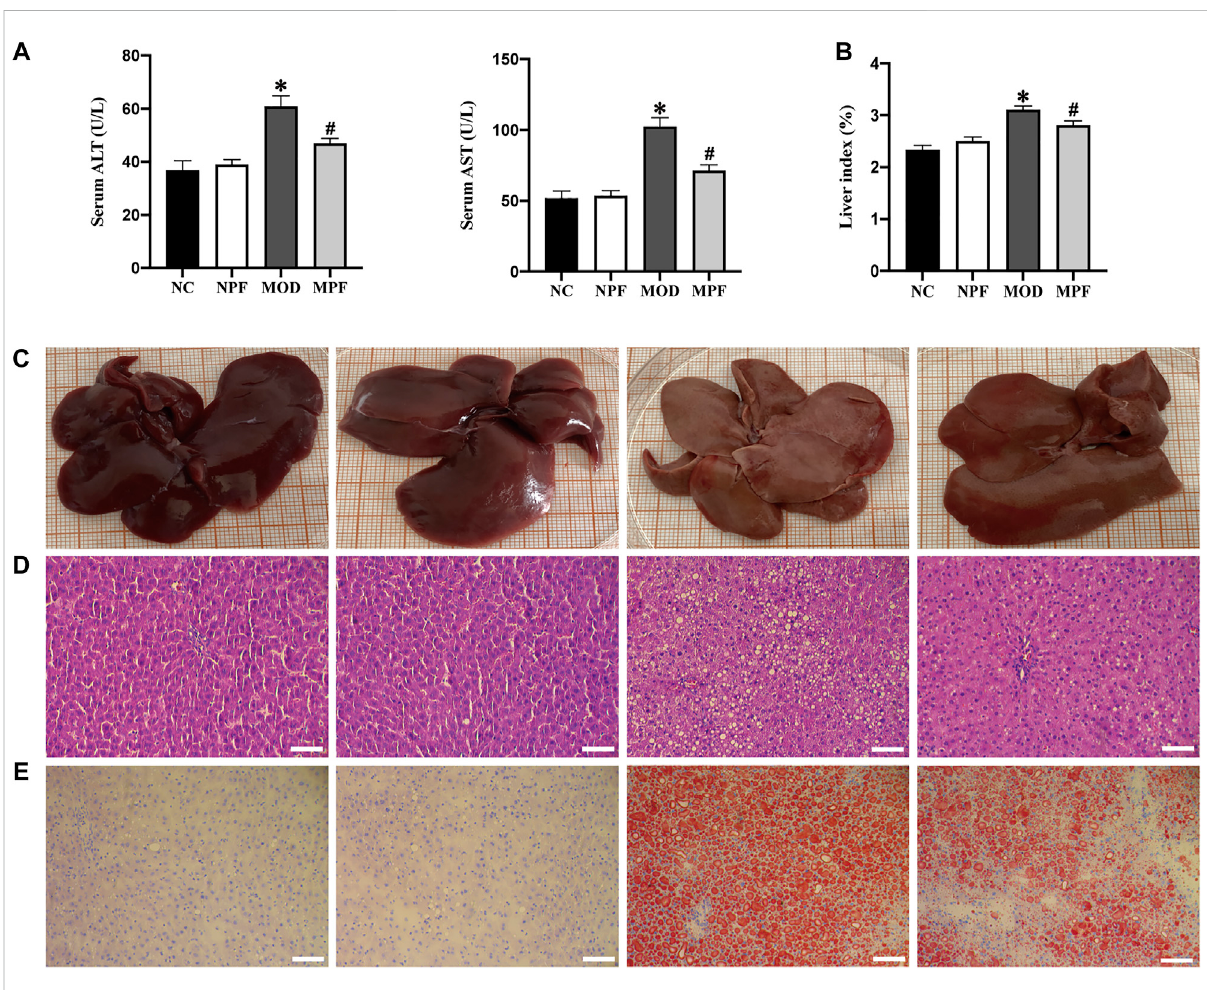
Effects of PF on liver function and histological changes in the liver. (A) Serum levels of ALT and AST activity. (B) Average liver index of rats in four groups. (C) Representative photos of rat liver in four groups. (D) Representative H and E staining histologic slices in four groups, (200×, scale bar = 100 μ m). (E) RepresentativeoilredOstaininghistologicslicesinfourgroups,(200×,scalebar=100 μ m).Theserumandliversampleswereobtained from the normal control group (NC), PF-treated control group (NPF), model group (MOD), and PF-treated model group (MPF). Data